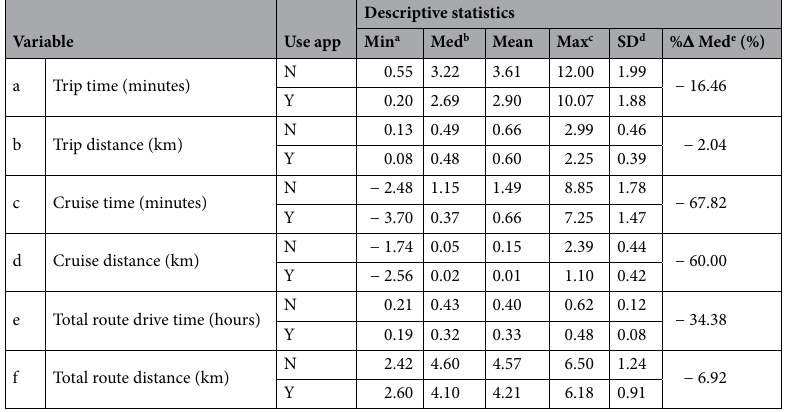
Table 2. Descriptive statistics of variables of interest. a Minimum; b median; c maximum; d standard deviation; e percentage change in median.